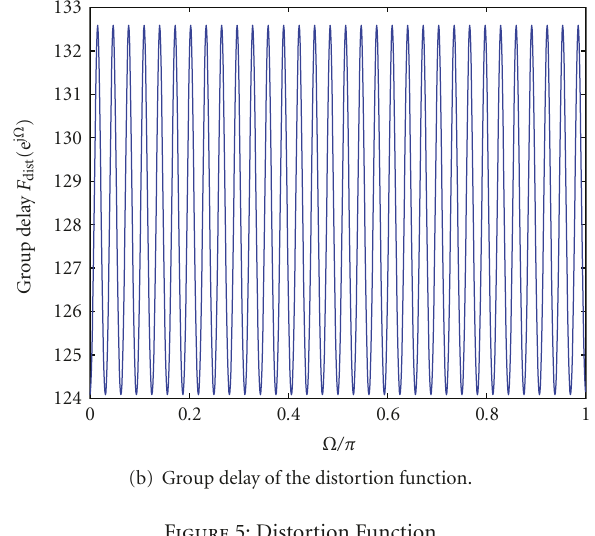
Figure 5: Distortion Function.